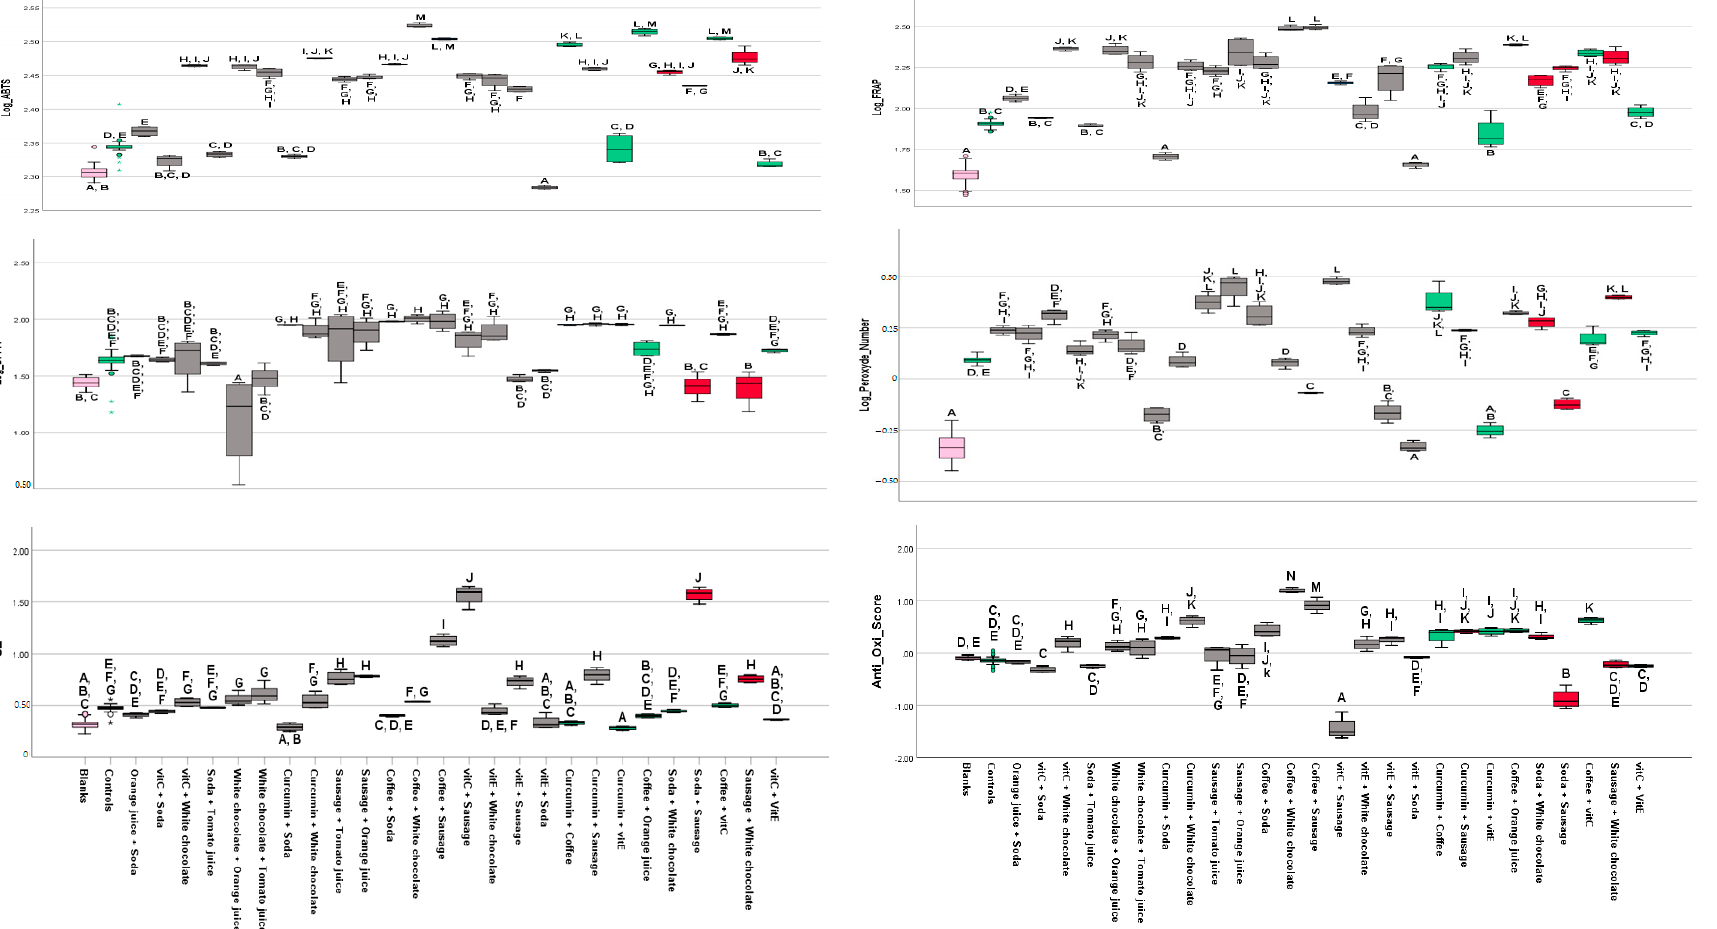
Figure 3. Multivariate analysis comparing antioxidant and pro-oxidant capacity of laboratory combinations of food items after in vitro digestion. Boxes not sharing the same superscript (capital letters) differ statistically significantly (Tukey’s post hoc test, p < 0.05). Log = All values are in logarithmic form. Pink color indicates the respective blank. Green colors represent presumably antioxidant-rich food combinations, red ones presumably pro-oxidant food combinations, and grey colors indicating a combination of one pro-and one antioxidant food item.